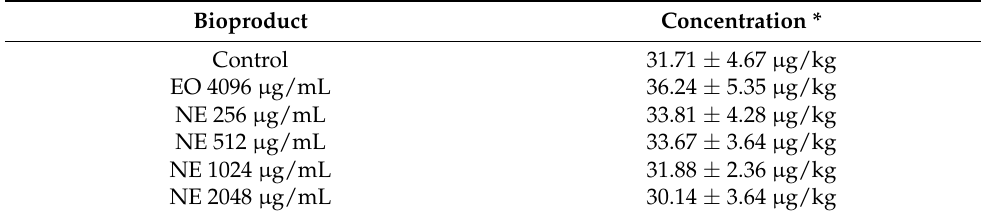
Table 8. AFB1 production by A. parasiticus colonies in the presence of EO and NE at 48, 72, and 96 h.